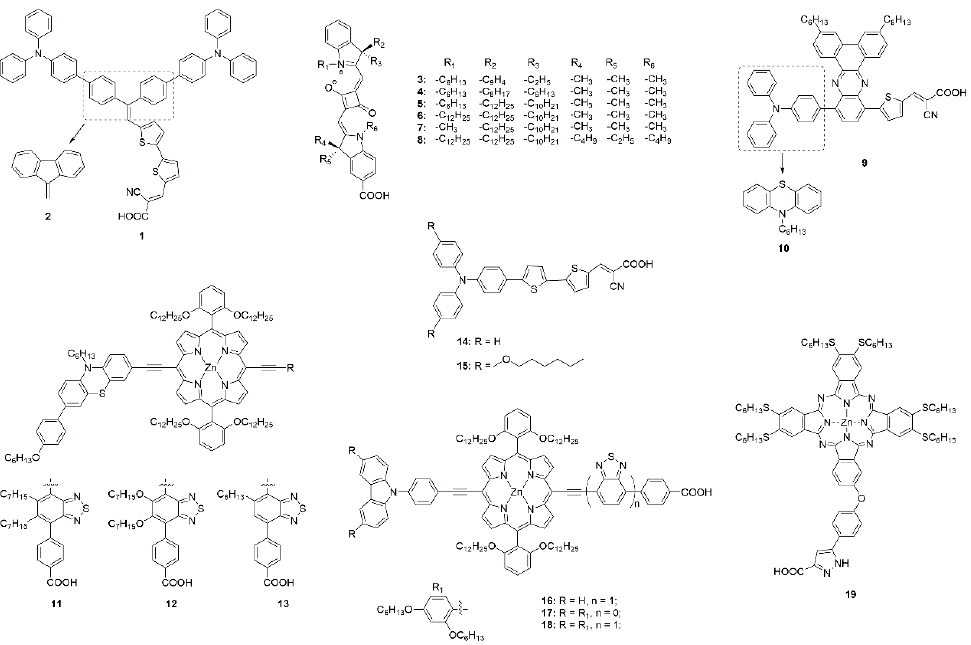
Figure 3. Chemical structures of dyes 1 – 19 . Table 1. The fabrication conditions and photovoltaic performance of DSSCs and